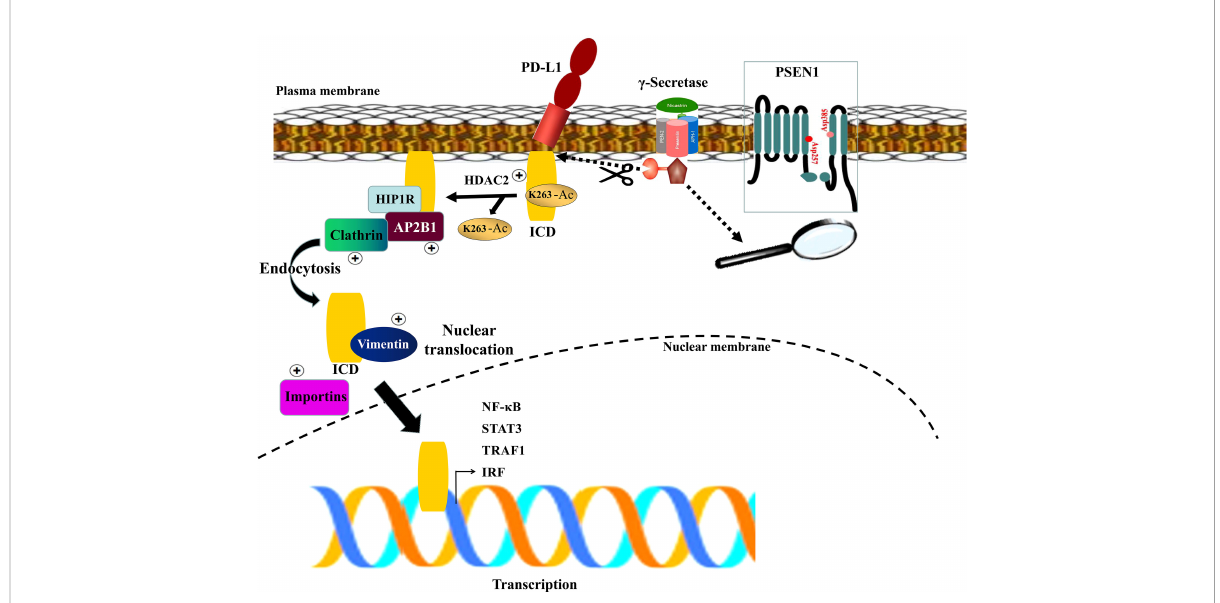
FIGURE 3 A schematic diagram of PSEN1-engaged PD-L1 nuclear translocation. The g -secretase complex is comprised of four components with Presenilin (PSEN1) as the catalytic core containing two catalytically active aspartates (Asp257 and Asp385) located in the NTF and CTF. Upon assembly with the other subunits, PSEN1 undergoes autoproteolysis resulting in the active complex which might facilitate PD-L1 truncation via potential proteolytic processing, liberating its active C-terminal fragment (ICD), and induce PD-L1 nuclear translocation through HDAC2-mediated deacetylation, clathrin-dependent endocytosis, vimentin-associated nucleocytoplasmic shuttling and importins-mediated nuclear import. Subsequently nuclear PD-L1 transactivates a panel of pro-in fl ammatory and immune response -related